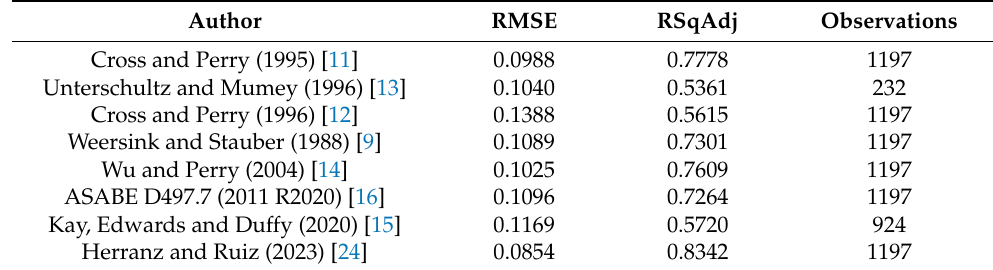
Table 6. Previous studies results.